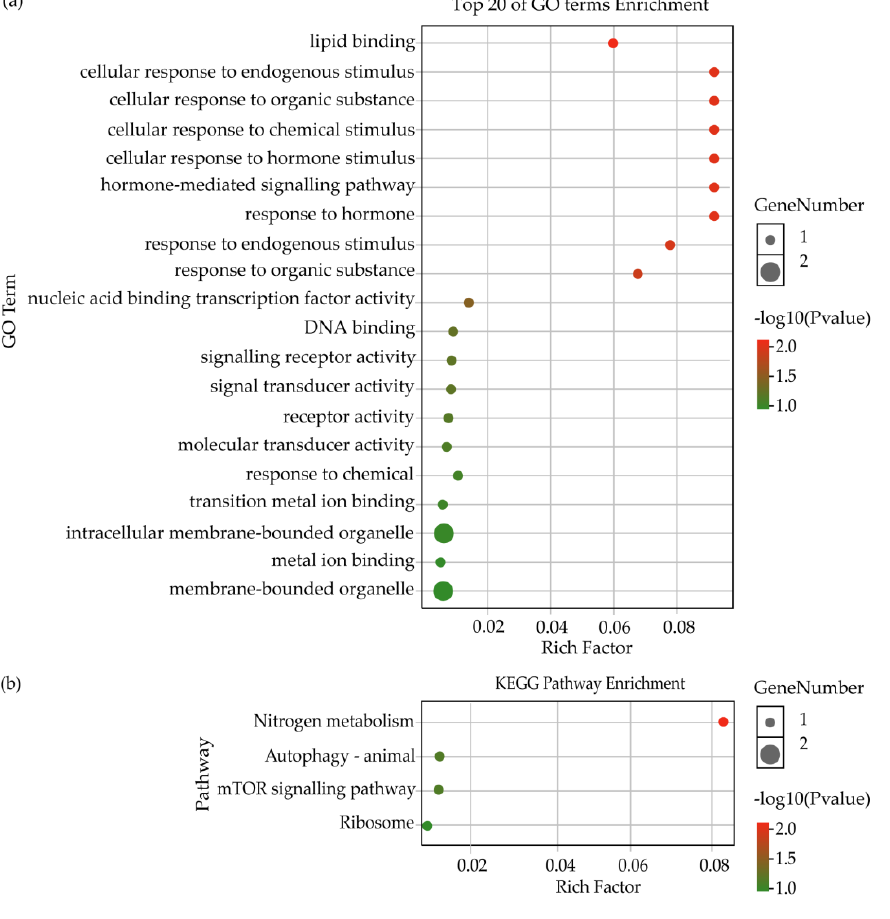
Figure 3. GO and KEGG enrichment analysis of target genes regulated by DElncRNAs from the intersection between NDB-vs-EDB and NDB-vs-LDB via the cis-regulatory mechanism. ( a ) Top 20 of GO terms enrichment analysis. ( b ) KEGG pathway enrichment analysis. Note: EDB referred to the waggling dancers after foraging on a feeder with 1.5 M sucrose solution in the first phase. NDB referred to the non-dancing bees after foraging on another feeder with 0.5 M sucrose solution replacing the feeder with 1.5 M sucrose solution in the second phase. LDB referred to the waggling dancers after foraging on the feeder with 1.5 M sucrose solution replacing the feeder with 0.5 M sucrose solution in the third phase.